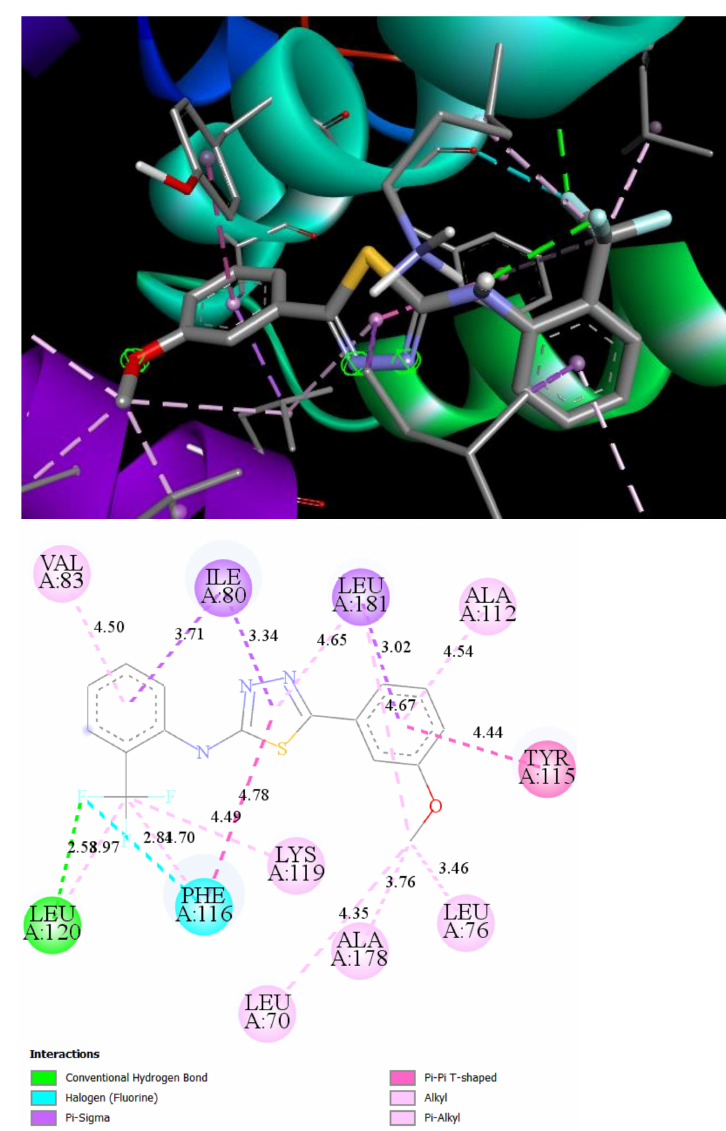
Figure 7. 2D and 3D interaction maps of ST10 with